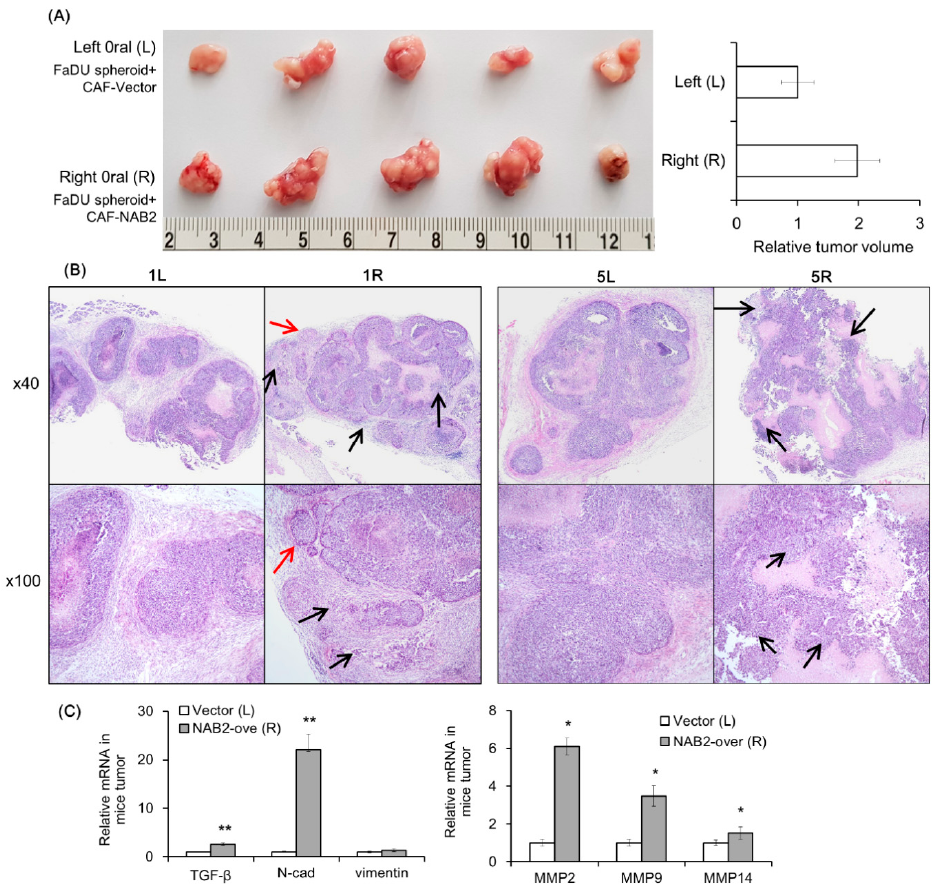
Figure 5. Effect of NAB2-overexpressing CAFs on the growth of FaDu spheroid-derived tumors in nude mice. FaDu spheroids (>400 μ m in diameter) were prepared in 96-well U-bottom ultra-low attachment plates. CAFs from P3 transfected with NAB2 overexpression or control vector; 50 FaDu spheroids and 5 × 10 5 CAFs transfected with NAB2 overexpression or control vector were co-injected into the oral mucosa of the left and right cheeks, respectively, of BALB/c mice. ( A ) Mice were sacrificed after 6 weeks and tumor size was measured. ( B ) Hematoxylin and eosin (H&E) staining was performed using tumor tissues from nude mice. The red and black arrows indicate some representative lobulated margins and increased invasion into the surrounding connective tissue in tumor, respectively. ( C ) mRNA expression of MMPs and invasion-related genes in tumor tissues was investigated at the same time. * p < 0.05, ** p <